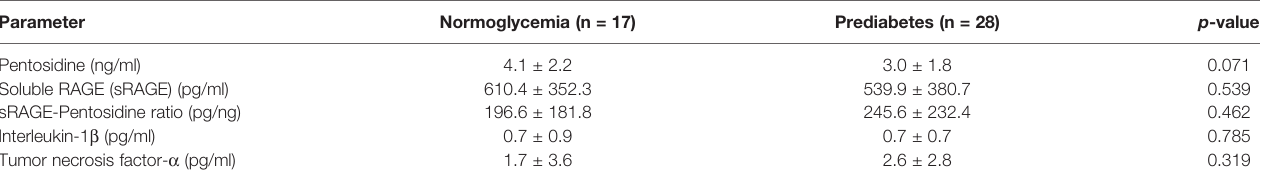
TABLE 3 | Serum Pentosidine, sRAGE and In fl ammation Markers in the Study Participants. Parameter